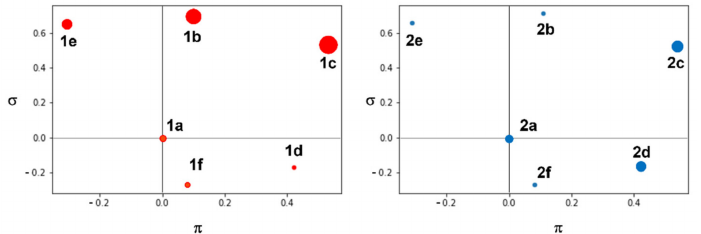
Figure 5. Parallel Craig plots for most active sulfonate (red circles) and sulfonamide (blue circles) derivatives on left - and right -hand sides, respectively. The circles are sized in proportion to the percentage of in vitro human aromatase inhibition.